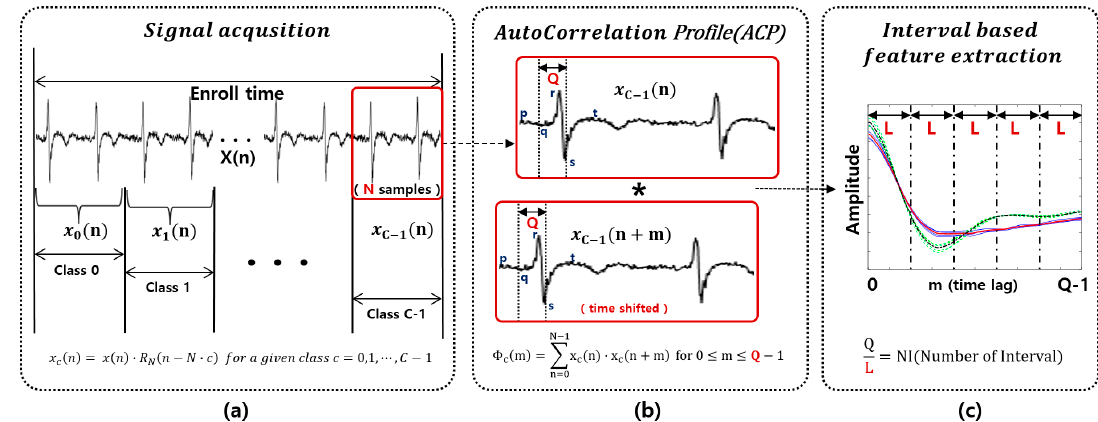
Figure 6. Symbol descriptions: ( a ) N is the update cycle of the verification process; ( b ) Q is the time-shifting size of the ACP process; ( c ) L is the size of an interval and the maximum length that satisfies the MSE ( ζ ) criterion.